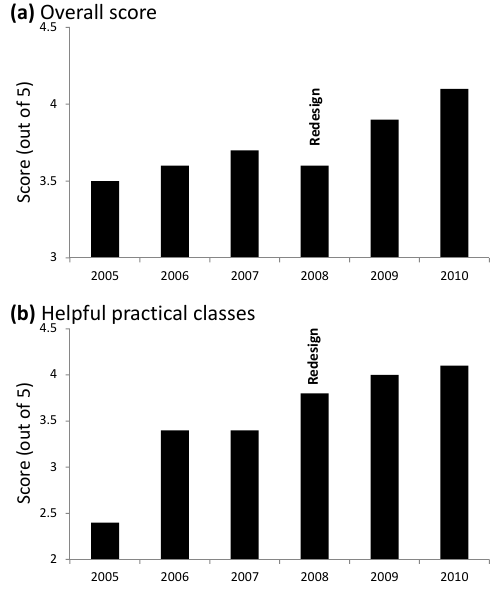
Fig. 4. Pre- and post-innovation cohort mean student feedback (a) overall scores and (b) scores for how helpful practical classes